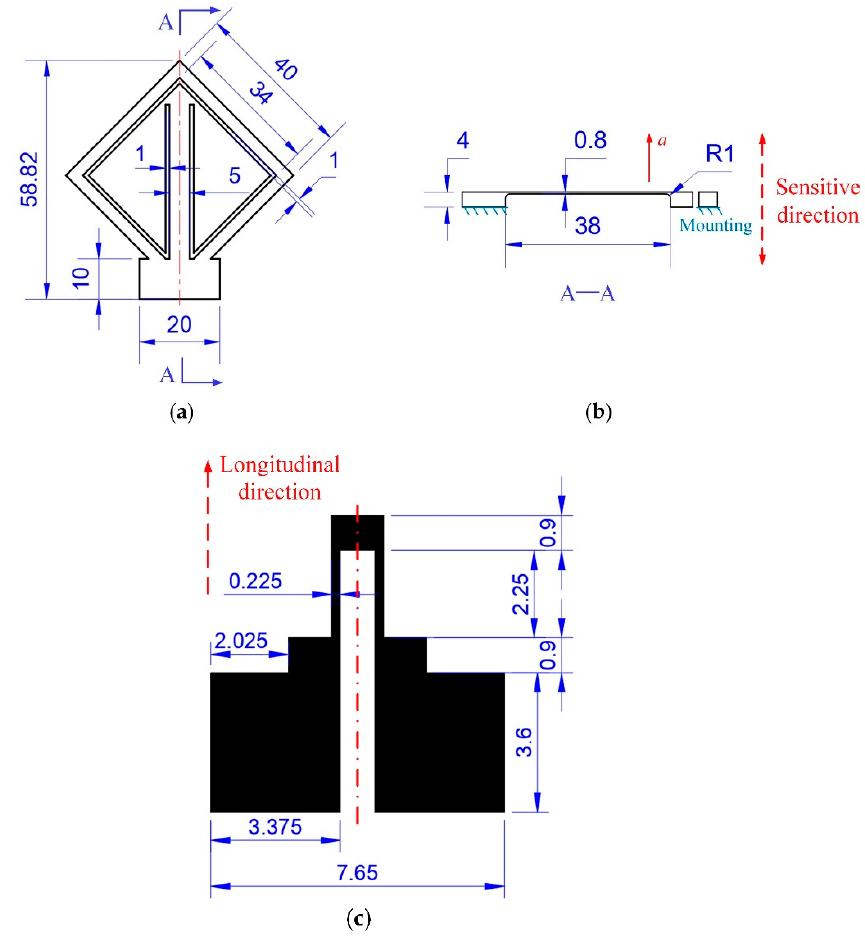
Figure 2. Dimensions of the sensor substrate: ( a ) top view; and ( b ) sectional view. ( c ) Dimensions of the strain gauge. Units: mm.